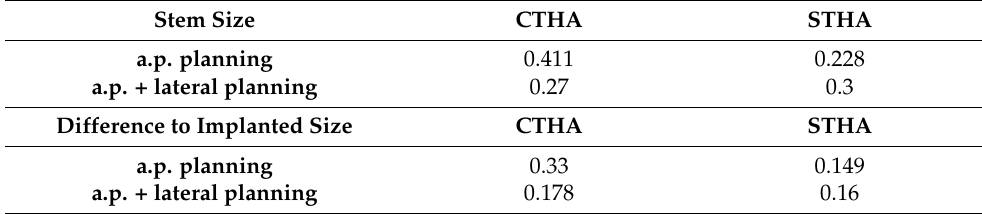
Table 4. Fleiss Kappa as value for the conformity between all the three raters.